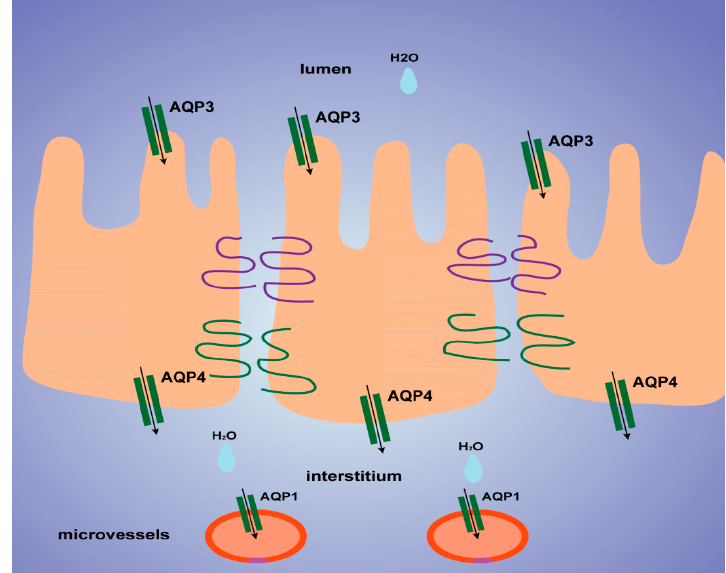
Figure 6. A possible transcellular route (aquaporins, AQPs) of water movement across the gastrointestinal tract epithelia. In the colon, water moves both in the absorption and in the secretion direction. AQP3 are localized at the apical side, and AQP4 at the basolateral side. Water is transported into or out of the mucosal microvessels through AQP1.